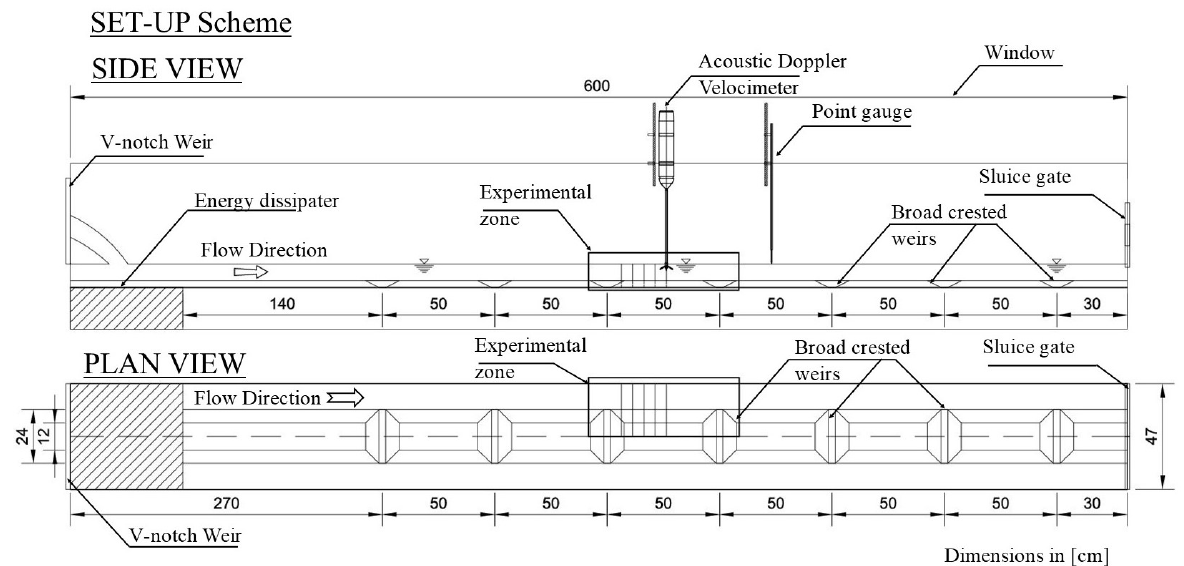
Figure 1. Experimental set-up of the flume with broad-crested weirs in the laboratory. The hydrodynamic conditions of the experiments were controlled with a Thomson Weir (upstream) and with a hinged crested gate (downstream). The shallow water flow rate was calculated with the calibrated rating curve of the Thomson weir and with a